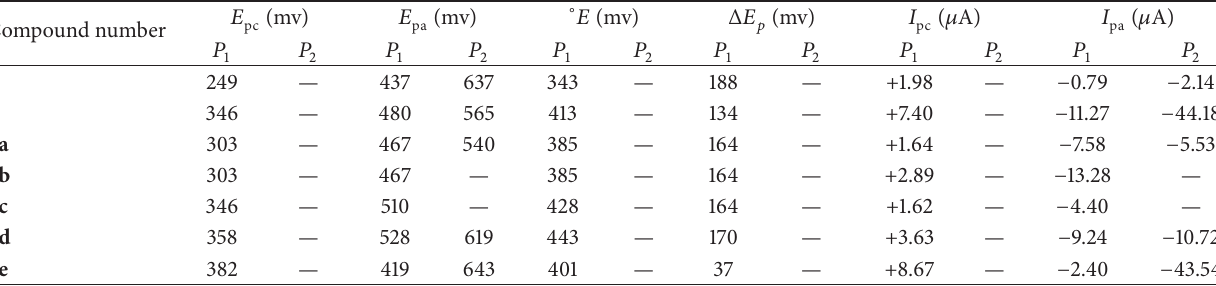
Table 3: Cyclic voltammetric parameters of monomer 4 , model compound 5 , Fc-polyazomethines 6a , 6b , 6c , 6d , and 6e at 20mVs